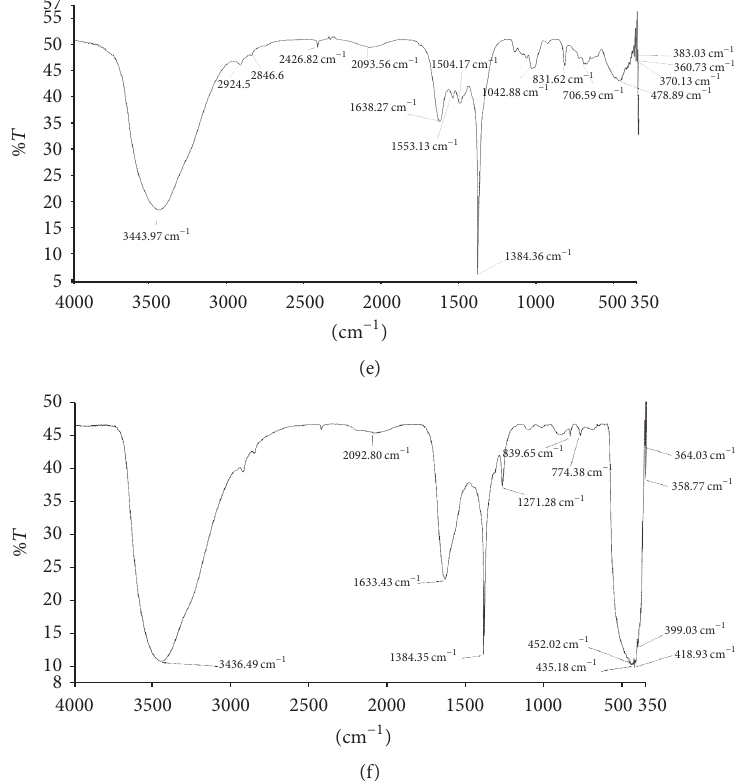
Figure 6: (a–f) FT-IR of ZnO and their corresponding ZnO:H samples at 0, 0.05, and 0.15% starch content of precursor solutions. (a) FT-IR of zinc oxide; ZnO synthesized using precursors in deionized water only, 0% starch (control). (b) FT-IR of hydrogenated zinc oxide; ZnO:H synthesized from precursors in deionized water only, 0% starch. (c) FT-IR of zinc oxide; ZnO synthesized using precursors in 0.05% starch solution. (d) FT-IR of hydrogenated zinc oxide; ZnO:H synthesized from precursors in 0.05% starch solution. (e) FT-IR of zinc oxide; ZnO synthesized using precursors in 0.15% starch solution. (f) FT-IR of hydrogenated zinc oxide; ZnO:H synthesized from precursors in 0.15% starch